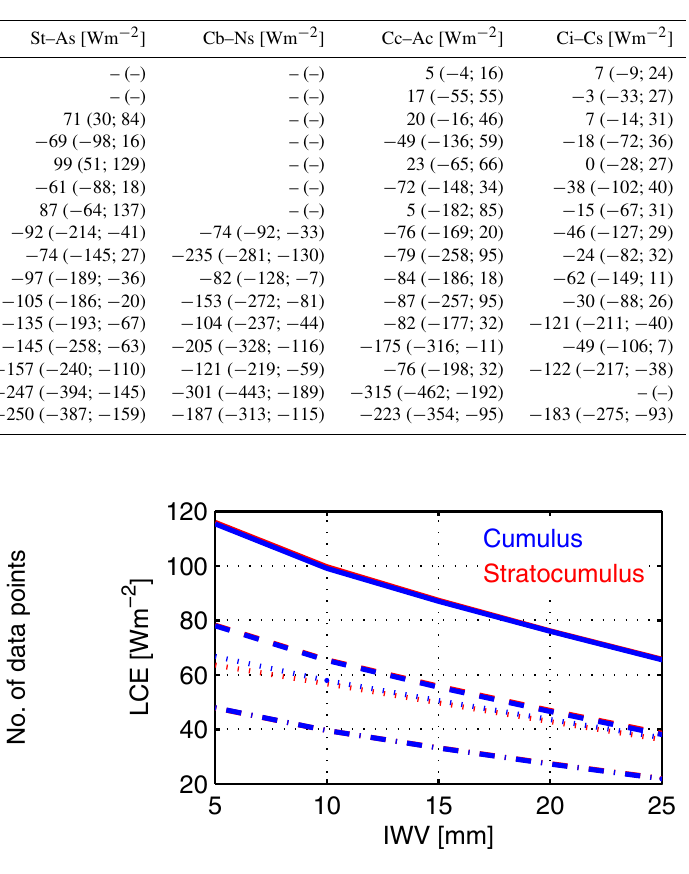
Figure 6. Dependence of the LCE on integrated water vapour (IWV) modelled for cumulus (blue) and stratocumulus (red) clouds. Solid line: summer standard atmosphere (SSA) and cloud-base height (CBH) of 1km. Dotted line: SSA, CBH = 5km. Dashed line: winter standard atmosphere (WSA), CBH = 1km. Dashed-dotted line: WSA, CBH =